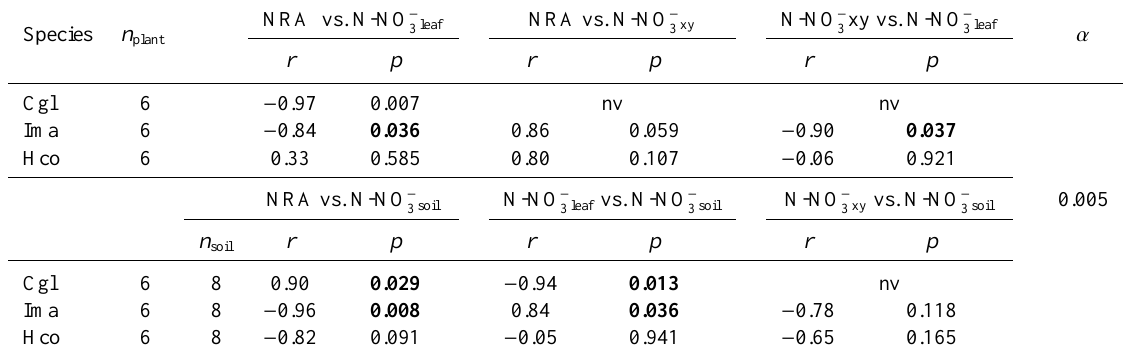
Table 4. Pearson’s correlation matrix of nitrogen use variables. Nitrate reductase activity (NRA), nitrate in leaves (N-NO − 3leaf ), xylem sap (N-NO − 3xy ) and in soil (N-NO − 3soil ) for Cgl ( Cecropia glaziovi ), Ima ( Inga marginata ) and Hco ( Hymenaea courbaril ). nv – not verified. Bold data represent a significant